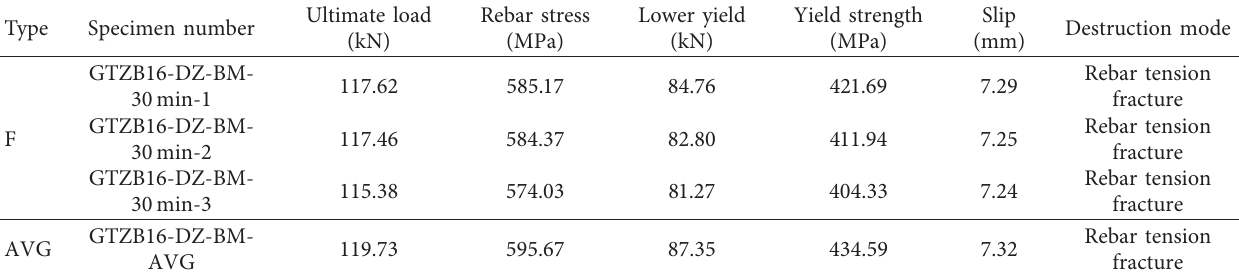
Table 9: Experiment data of overtime grouting specimens.